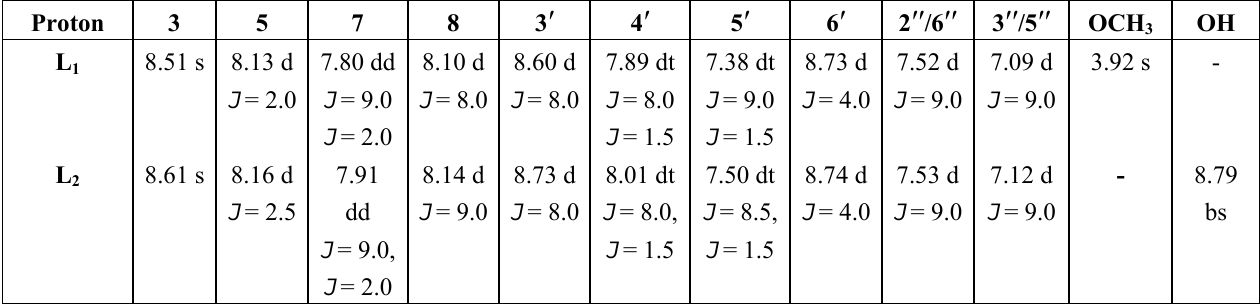
and L . Coupling constants in 1 2